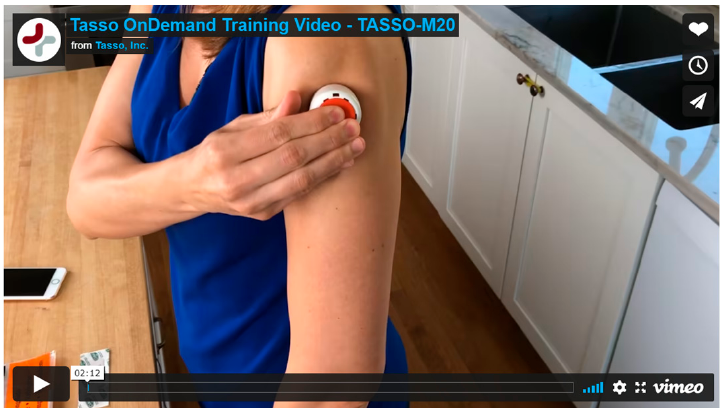
Figure 1. Tasso home-based viral load test device demonstration video (available at https://www.tassoinc.com/tasso-m20-video – Accessed January 29, 2022).